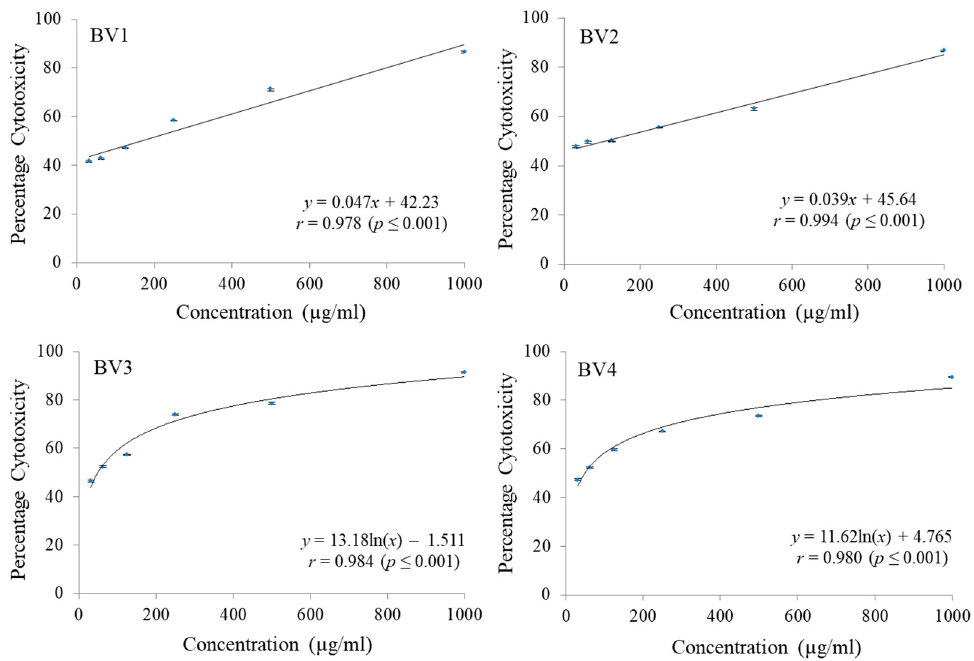
Figure 7. The percentage cytotoxic activity of compounds isolated from Bauhinia variegata L. bark against MCF-7 cell line. BV1 = kaempferol; BV2 = stigmasterol; BV3 = protocatechuic acid methyl ester; BV4 = protocatechuic acid.